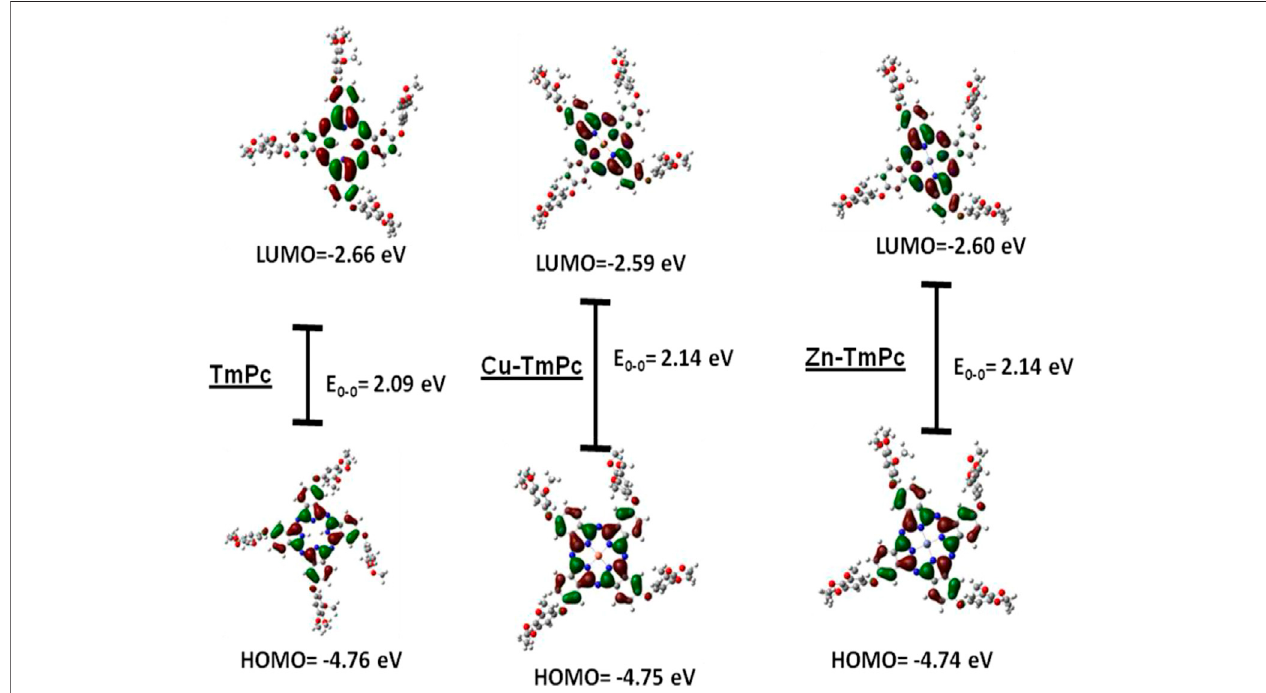
FIGURE 3 | Frontier HOMO and LUMO of TmPc , Cu-TmPc and Zn-TmPc .